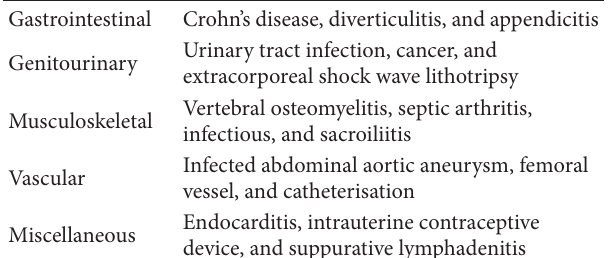
Table 2: Conditions associated with secondary iliopsoas abscess [18].